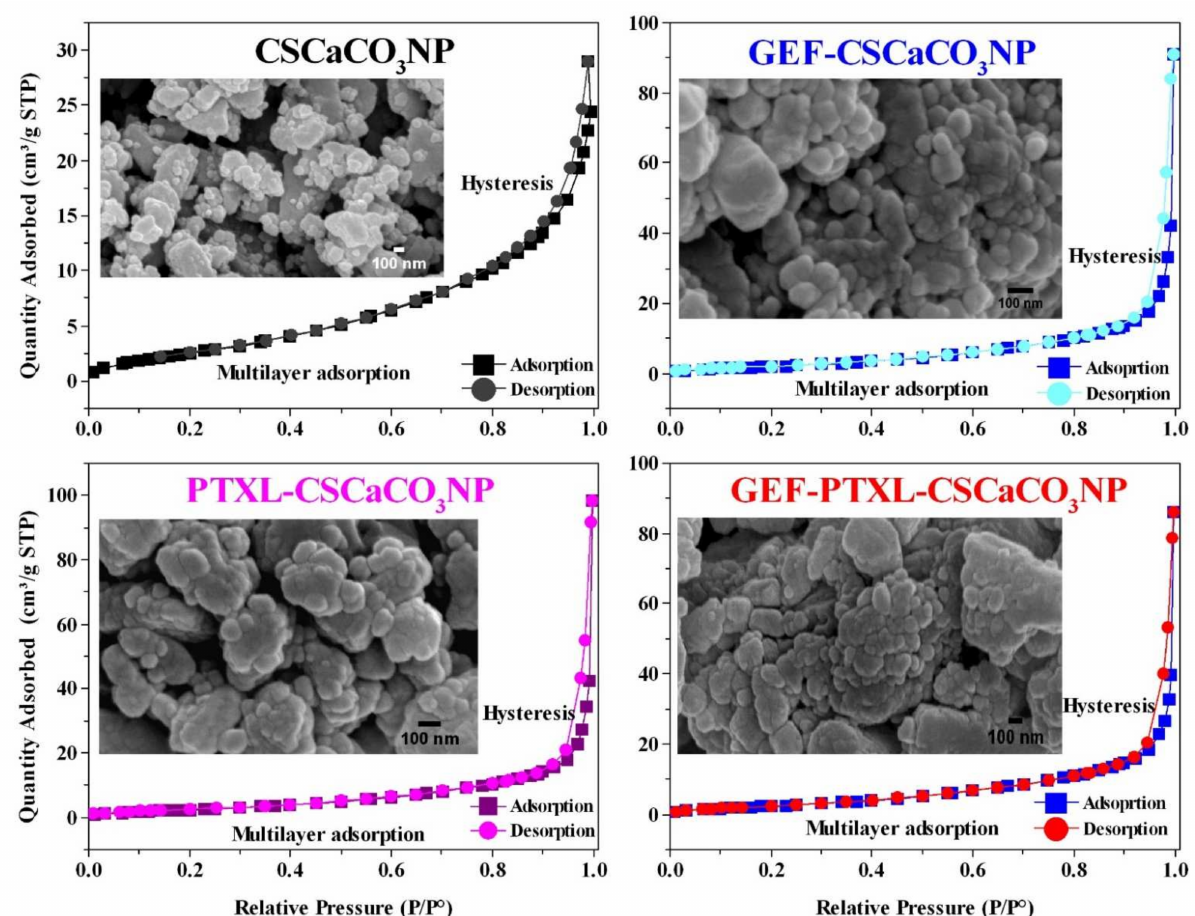
Figure 3. FESEM representative images of CSCaCO 3 NP, GEF-CSCaCO 3 NP, PTXL-CSCaCO 3 NP, and GEF-PTXL-CSCaCO 3 NP (Scale bar: 100nm) and the corresponding nitrogen adsorption desorption isotherms with its characteristic hysteresis. Plotted with Relative pressure (P/P 0 ) on the x -axis and Amount of Nitrogen adsorbed (cm 3 /g) on the y -axis.